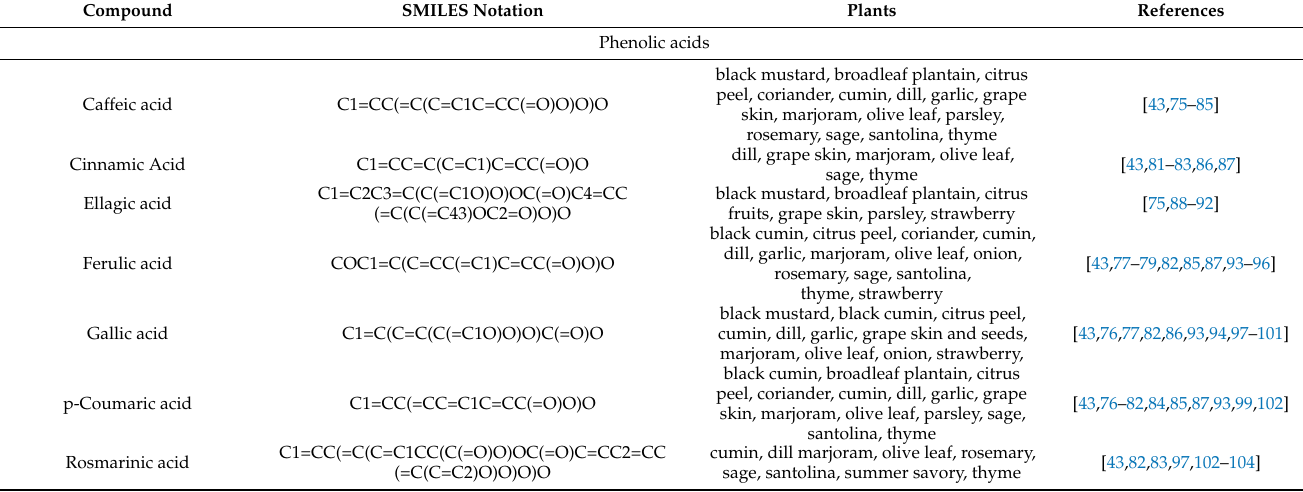
Table 2. Occurrence of phytochemicals in Mediterranean plant materials and their SMILES